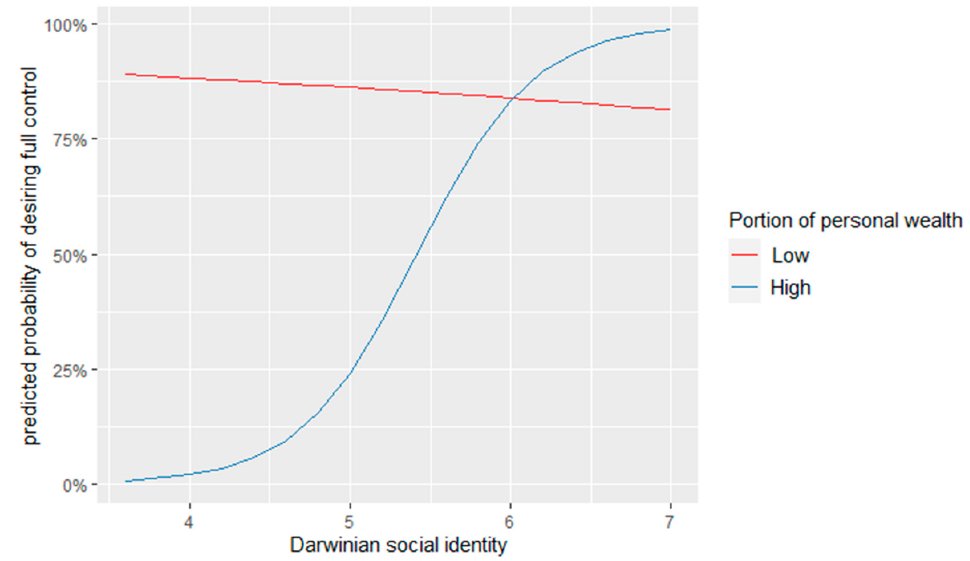
Figure 2. Interaction of portion of personal wealth and entrepreneurs’ Darwinian social identity for the desire to have full control. Note: With portion of personal wealth low = mean − S.D., and high = mean + S.D.